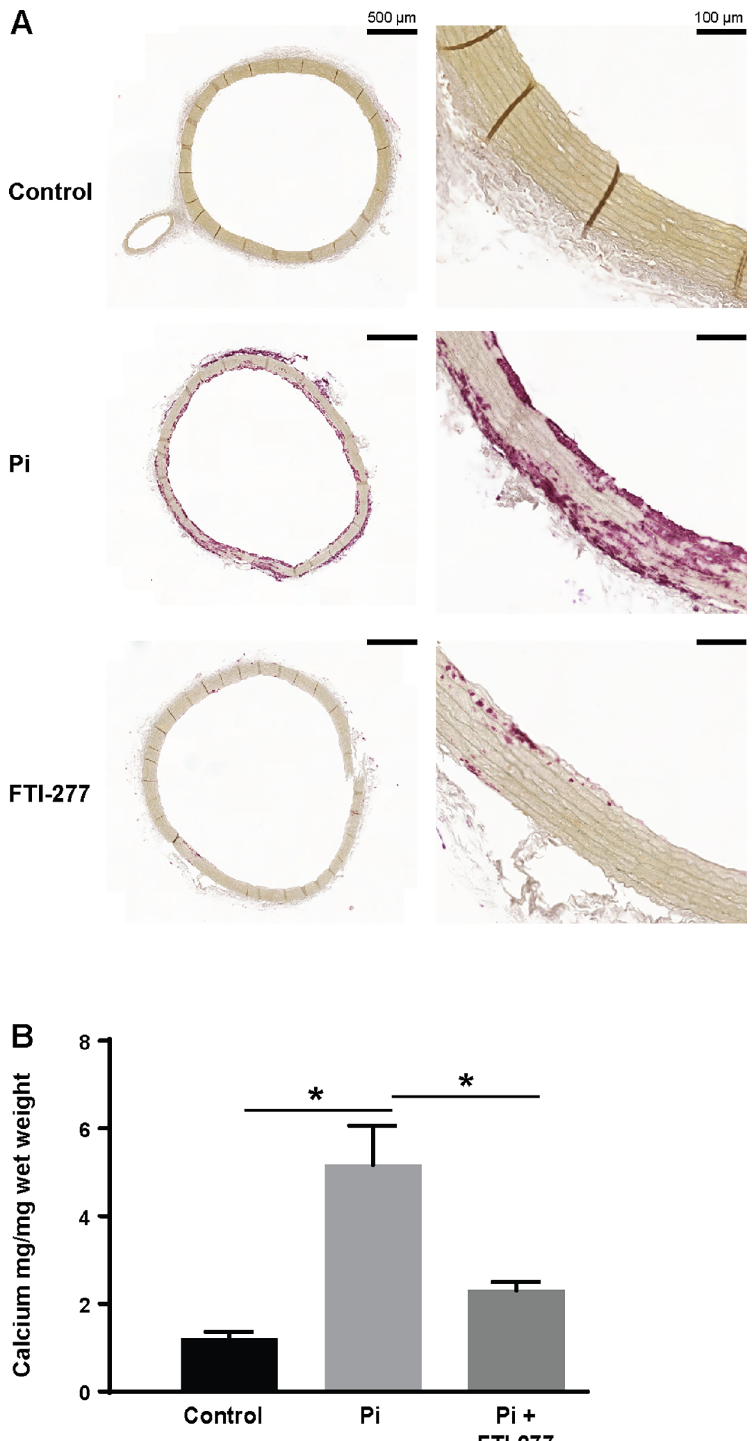
Fig 6. FTI-277 inhibits phosphate-induced mineralization of aortic rings from uraemic rats. Aortic rings from uraemic rats in end stage renal failure were incubated in control medium (Con; serum-free DMEM), phosphate medium (Pi; serum-free DMEM + 3.3 mM phosphate, 3.75 U/ml alkaline phosphatase), or phosphate medium + FTI- 277 (10 μM) for 10 days. ( A ) Representative alizarin red stained sections of aortic rings from uraemic rats; bar = 500 μm (left panel) and 100 μm (right panel). ( B ) Quantification of mineralization in the aortic rings using the O-